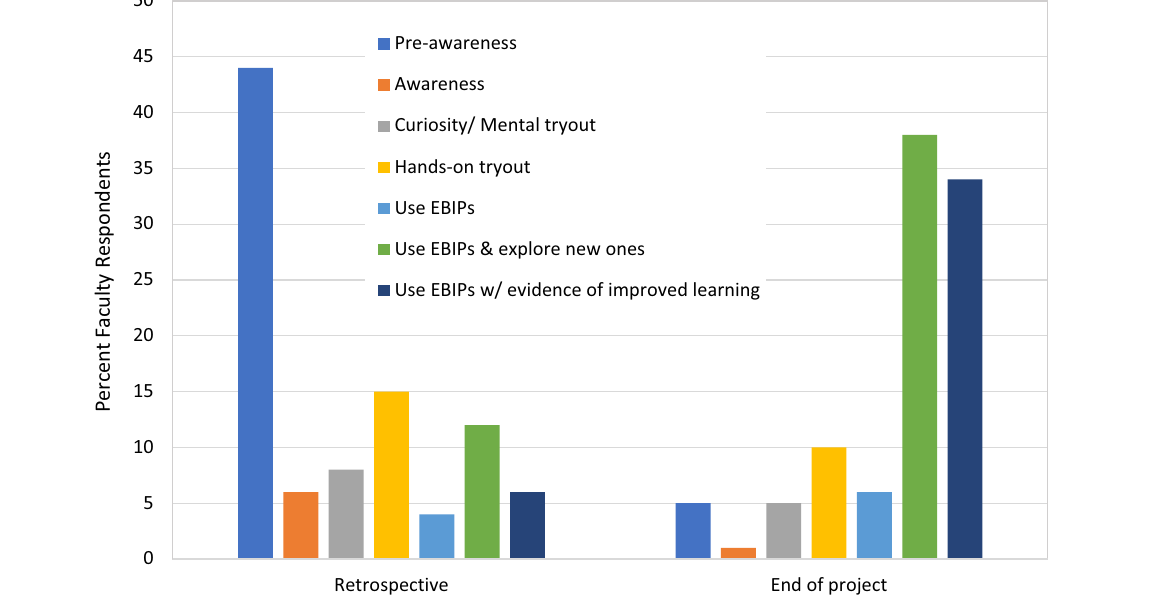
Fig. 3 Distribution of EBIP adoption stages for faculty in all STEM departments at the beginning (retrospective) and end of the